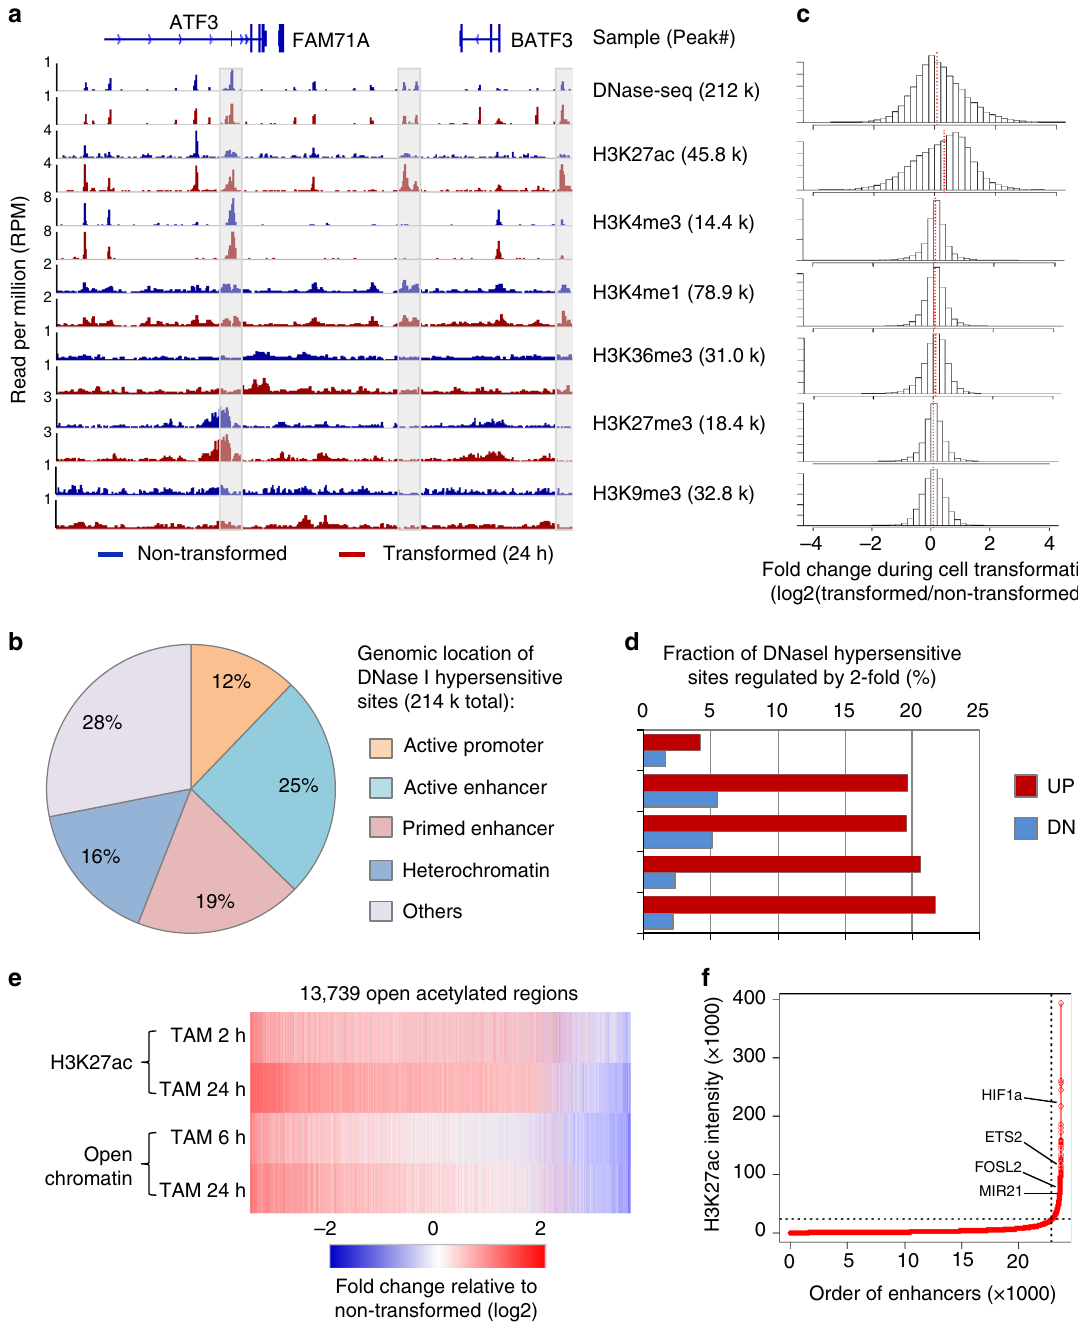
Fig. 2 Differential chromatin accessibility and histone modi fi cation during transformation. a Data for the indicated chromatin features before (blue) and after (red) transformation. Total peak numbers are shown. b Distribution of genomic locations of DNase I hypersensitive sites (DNase-seq peaks) classi fi ed by histone modi fi cations as active promoters (H3K4me3), active enhancers (H3K27ac), primed enhancers (H3K4me1), and heterochromatin (H3K27me3/ H3K9me3). Regions without any modi fi cation were grouped as “ Others ” . c Fold change of chromatin accessibility and histone modi fi cation